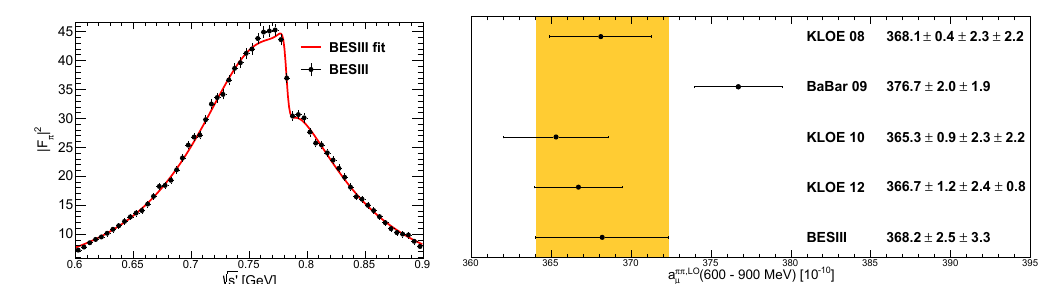
Figure 1. (From Ref. [15]) left: Pion FF determined at BESIII with the result of a Gounaris-Sakurai fit. right: Comparison of a ππ, LO µ (600 900MeV) determined at BESIII and by previous −